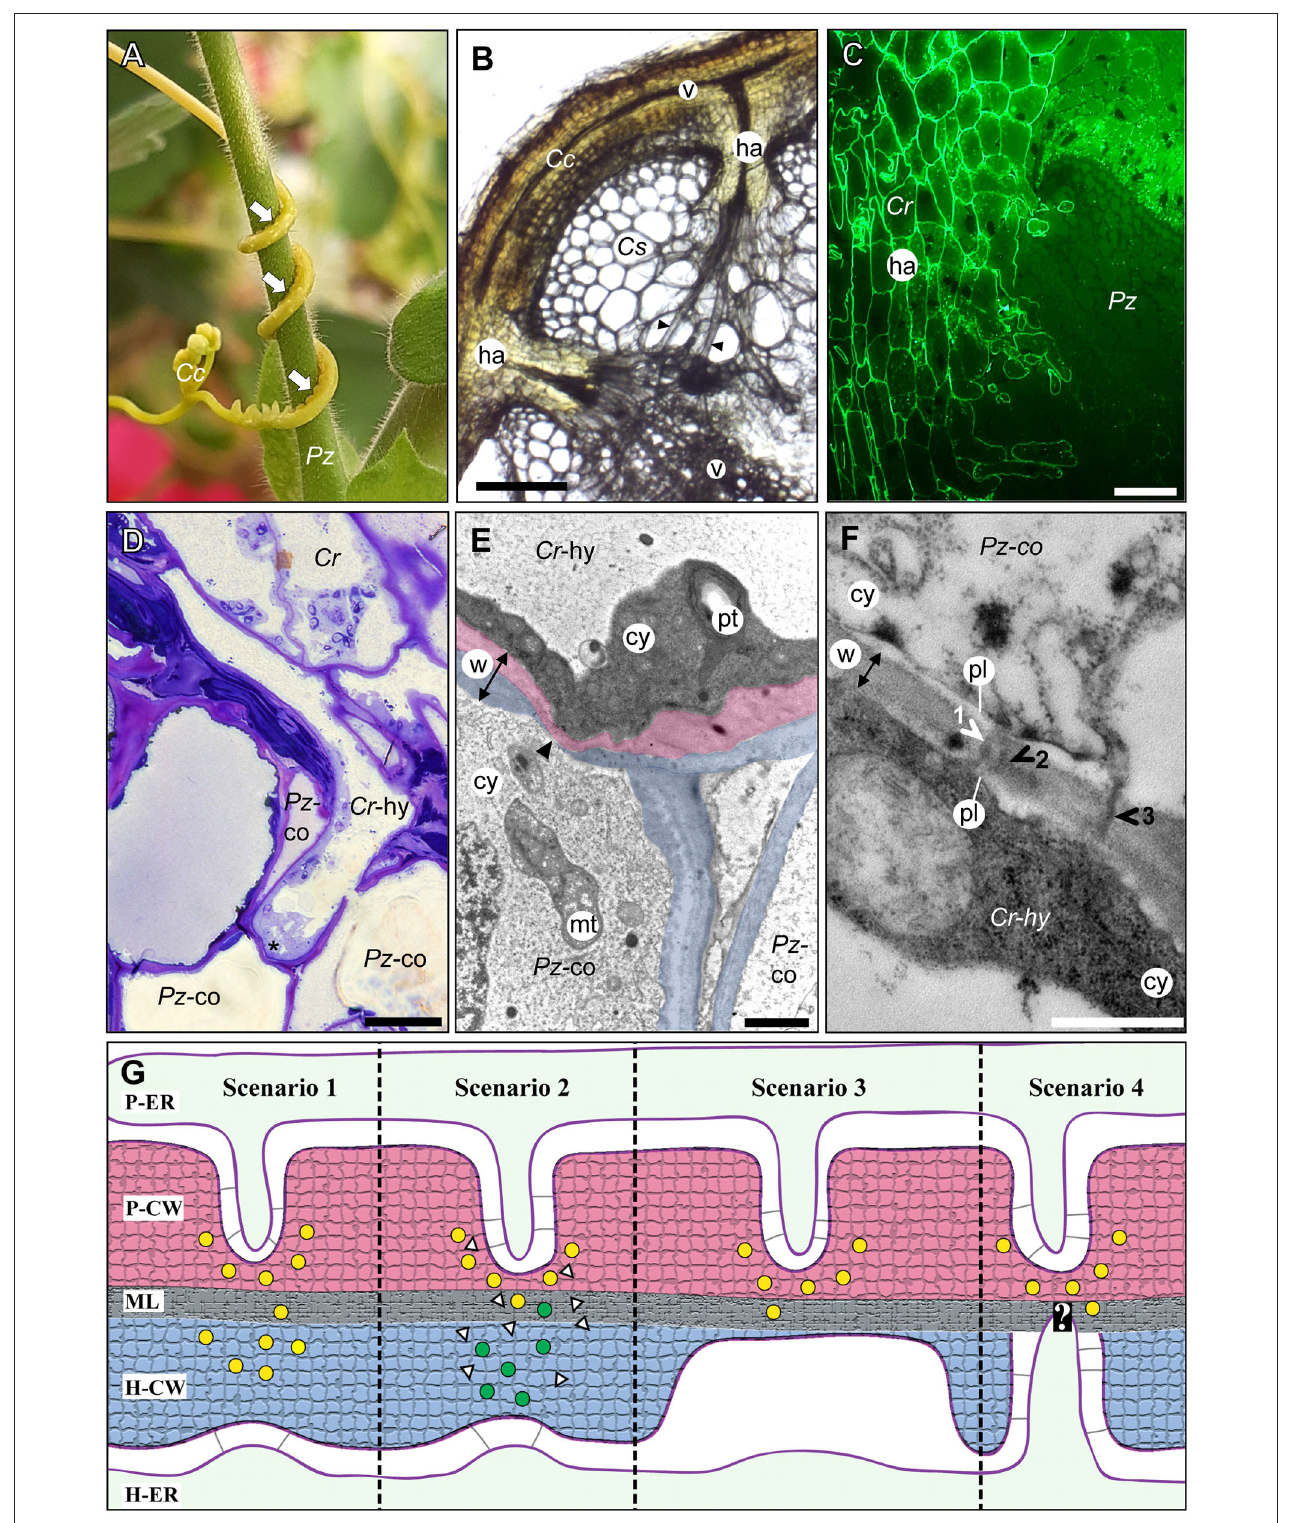
FIGURE 1 | The host/parasite feeding interface. (A) The yellow vine C. campestris ( Cc ) twines around its host Pelargonium zonale (Pz) making infection sites (arrows) where parasitic haustoria penetrate the host tissue. (B) Light micrograph of a transverse vibratome section of C. campestris ( Cc ) infecting Cucumis sativus ( Cs